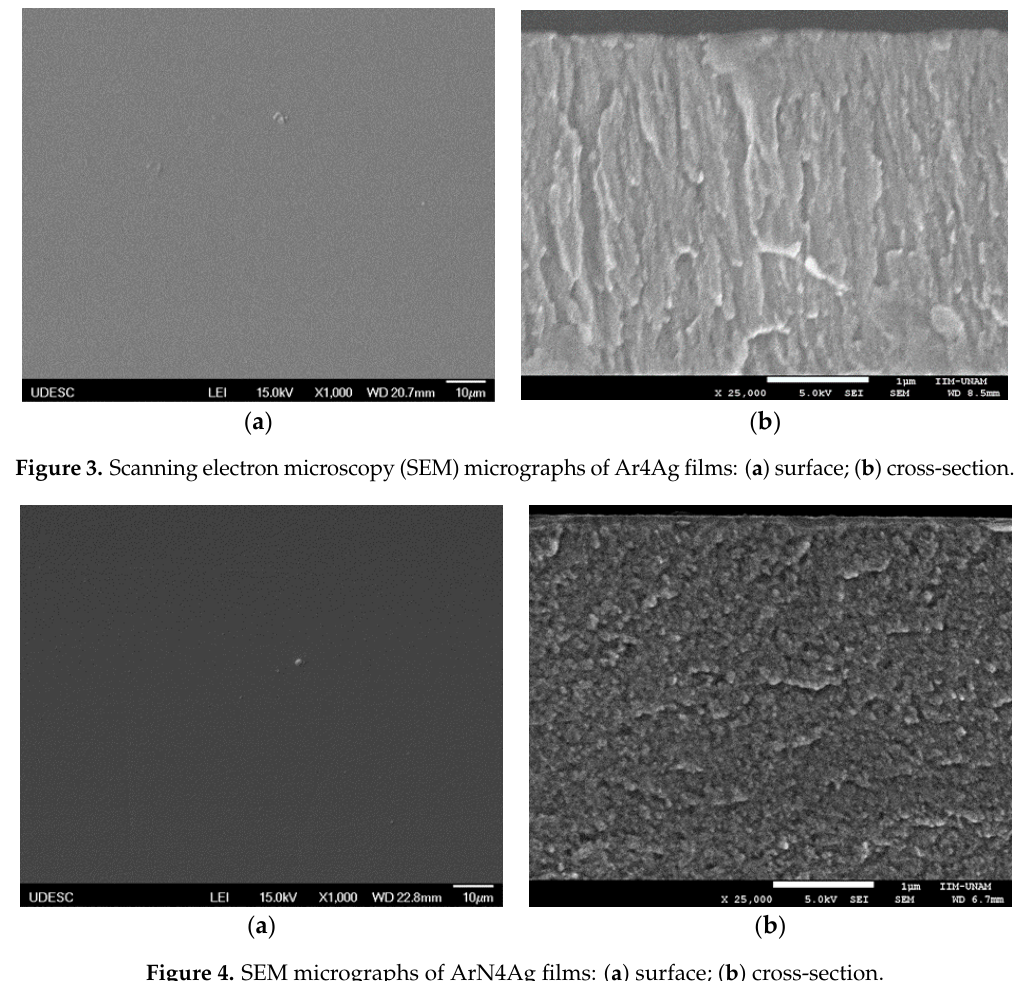
Figure 4. SEM micrographs of ArN4Ag films: ( a ) surface; ( b ) cross-section.